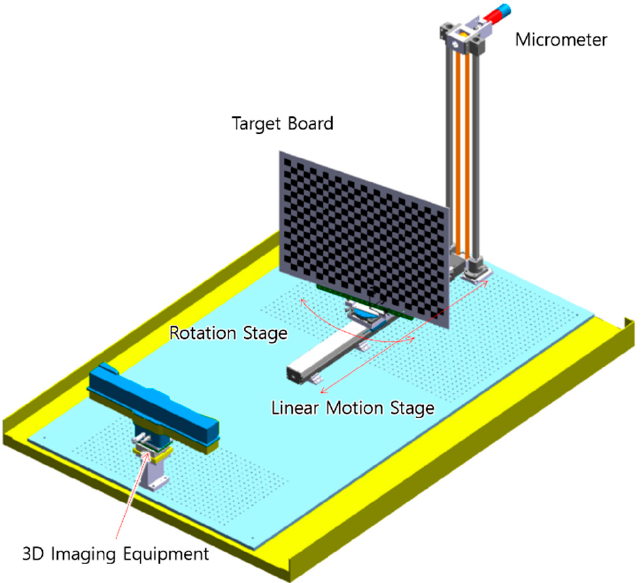
Figure 16. Design of experimental equipment.